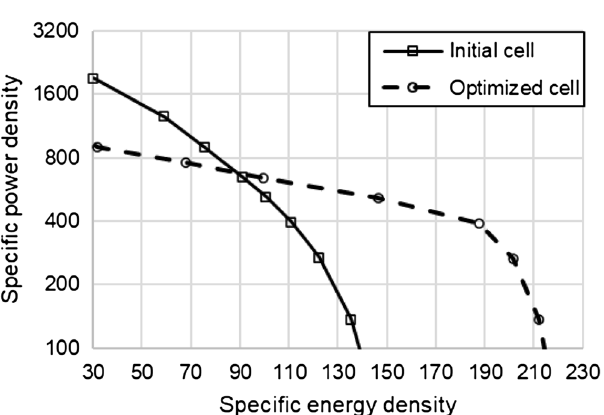
Figure 8. Specific energy density versus specific power density of initial cell and optimized